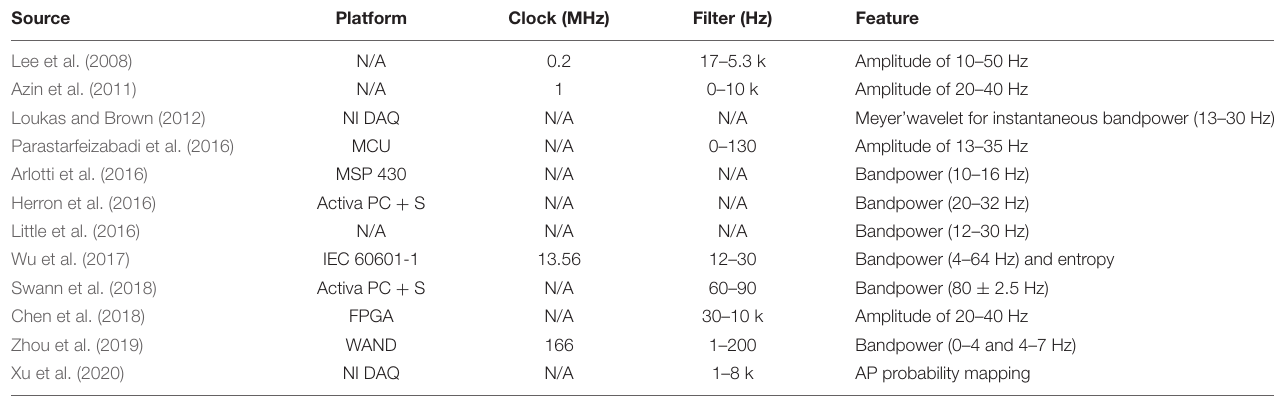
TABLE 5 | The closed-loop stimulation system for PD.